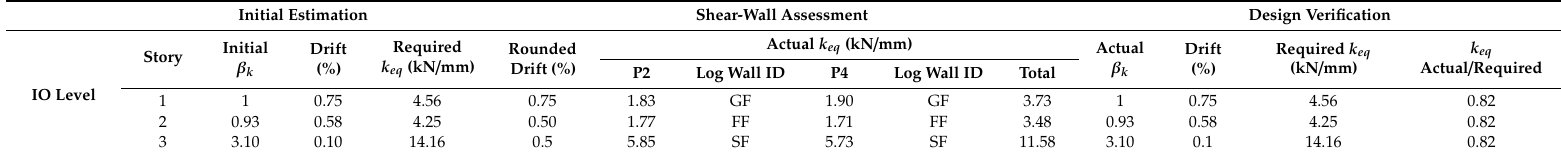
Table 9. IO level analysis (Y-direction), accounting for the EP shear-wall sti ff